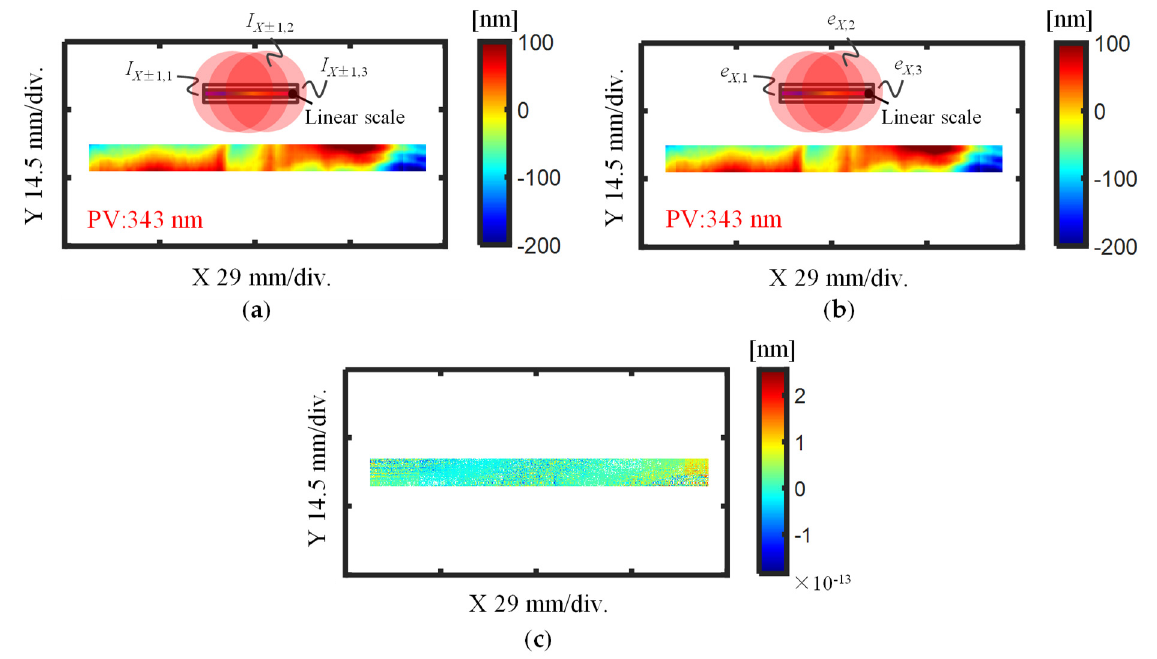
Figure 12. Evaluated X -directional pitch deviation of the linear scale through different stitching strategies. ( a ) Pitched deviation evaluated from stitched first-order diffracted beams; ( b ) Pitched deviation evaluated by stitching the pitch deviation from each sub-aperture; ( c ) Difference obtained from the two results in ( a , b ).